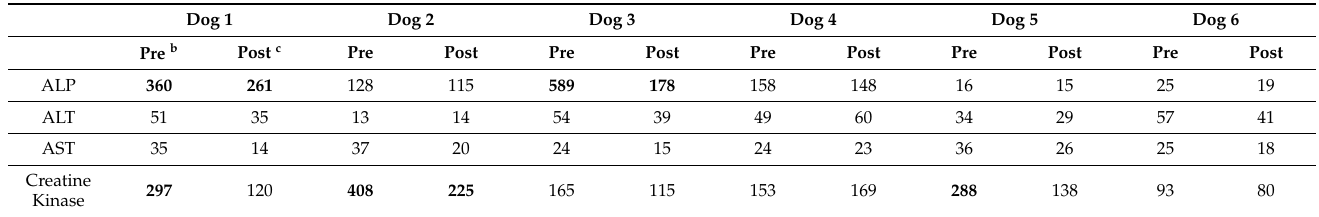
Table 7. Blood chemistry and hematology values in an 8-day repeat-dose AFPep study in dogs a